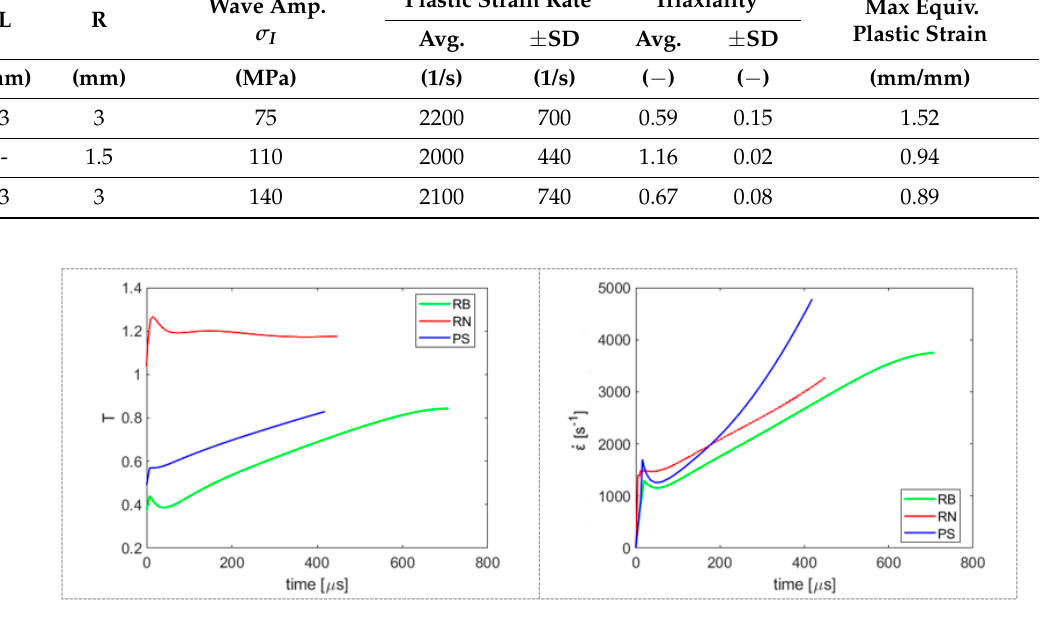
Figure 4. Estimated triaxiality and strain rate as a function of time for the selected specimen geometries and input wave amplitude.